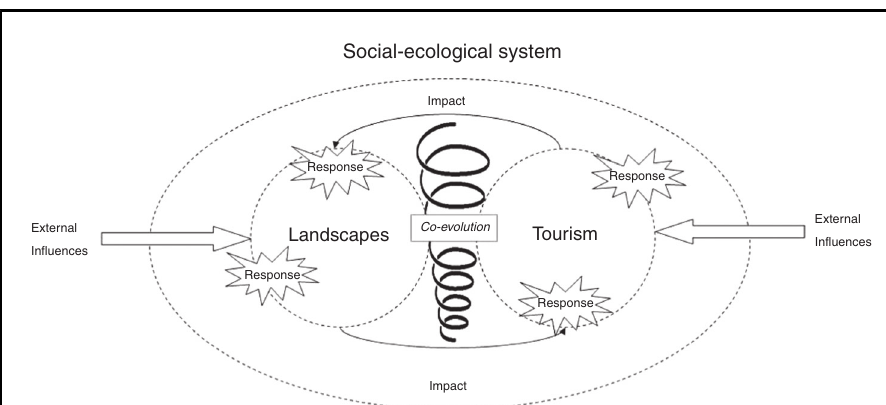
Figure 2 Co-evolutionary behaviour of the integrated tourism-landscape system Social-ecological